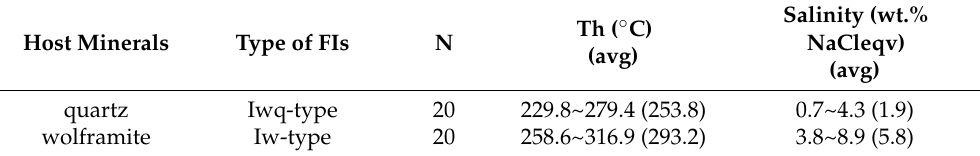
Table 5. Homogenization temperature and salinity data of wolframite and coexisting quartz.